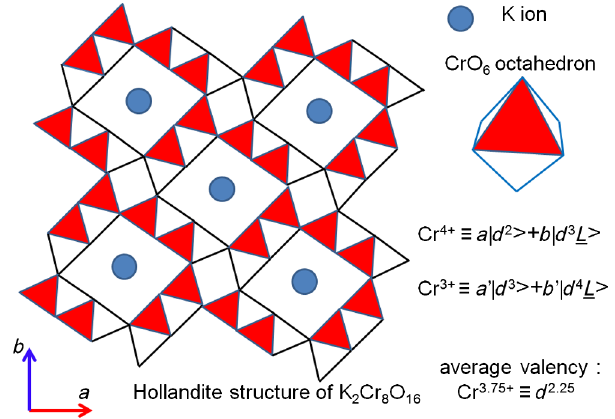
FIG. 1. The tunnel framework structure of the hollandite K 2 Cr 8 O 16 . As seen in the ab plane, the hollandite structure consists of tunnels made out of double chains of CrO 6 octahedra, stacked along the c axis. The average valency of Cr ions is Cr 3 . 75 þ , which formally corresponds to Cr 4 þ ð d 2 Þ and Cr 3 þ ð d 3 Þ states in a 3 ∶ 1 ratio (2.25 d electrons = Cr). The ground state has comparable contributions from d n L 0 ( ≡ d n ) and d n þ 1 L 1 ( L 1 ∶ ligand hole) for the Cr 3 þ and Cr 4 þ